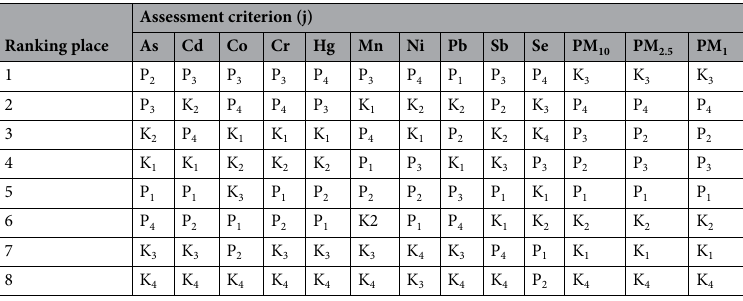
Table 4. Single-criterion assessment—rankings of objects examined in the research.